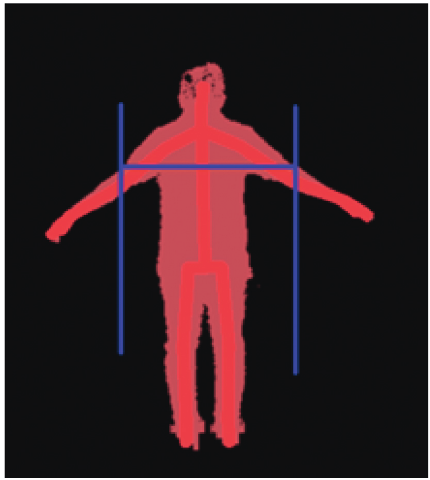
Figure 13: Incorrect T-pose.